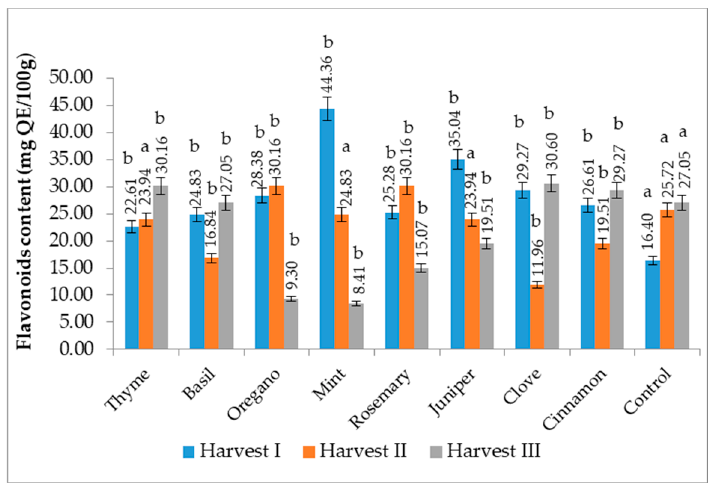
Figure 8. Flavonoid content (FC) of the samples before (Harvest I), after (Harvest II) the use of EOs in the supplementary food of bee families, respectively after the first harvest (rapeseed) (Harvest III). Different letters between control and samples indicate significant differences ( p < 0.05) among these values according to the t -test.